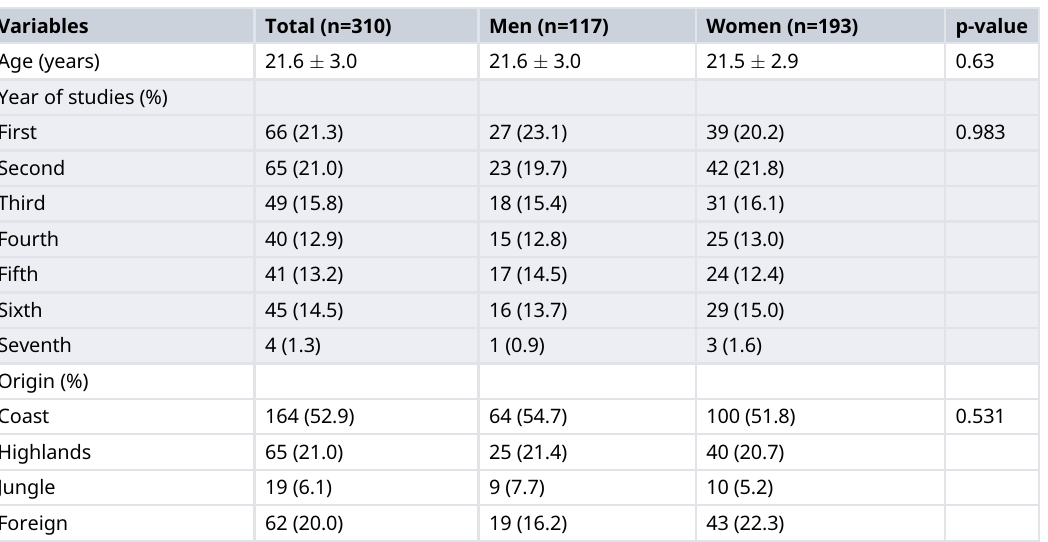
Table 1. General characteristics of medical